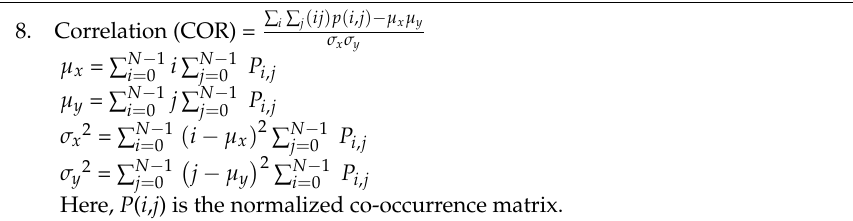
Grey Level Co-occurrence Matrix (GLCM) Based Texture Parameter